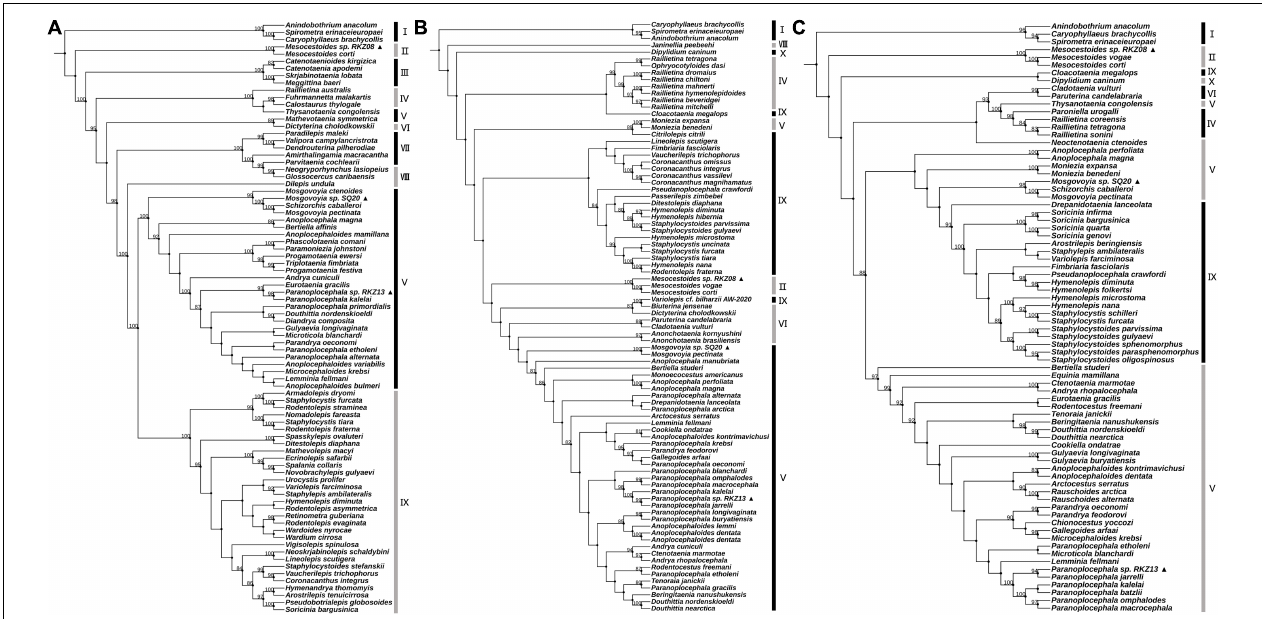
FIGURE 1 | Maximum likelihood analyses of the four “putative new species” with other Cyclophyllidea species, except for Taeniidae, based on simplified 28S rDNA (A) , cox 1 (B) and nad 1 (C) fragments. Alternating black and gray bands are used to classify different genera in the Taxonomy of NCBI, The Roman numerals to the right of the bands represent outgroup and different genus names (i.e., I: outgroup, II: Mesocestoididae, III: Catenotaeniidae, IV: Dipylidiidae, V: Anoplocephalidae, VI: Paruterinidae, VII: Gryporhynchidae, VIII: Dilepididae, IX: Hymenolepididae, X: Dipylidiidae). The (cid:78) after the species name represents “putative new species”. Bootstrap frequency support values are stated only for nodes where >